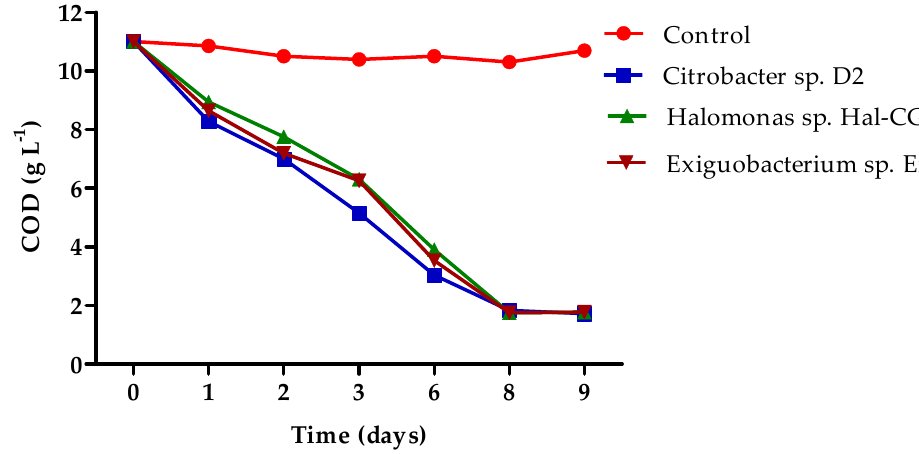
Figure 3. Decrease of COD concentration (g L − 1 ) over time in bilge water (high range COD) after cultivation with isolated bacterial strains.